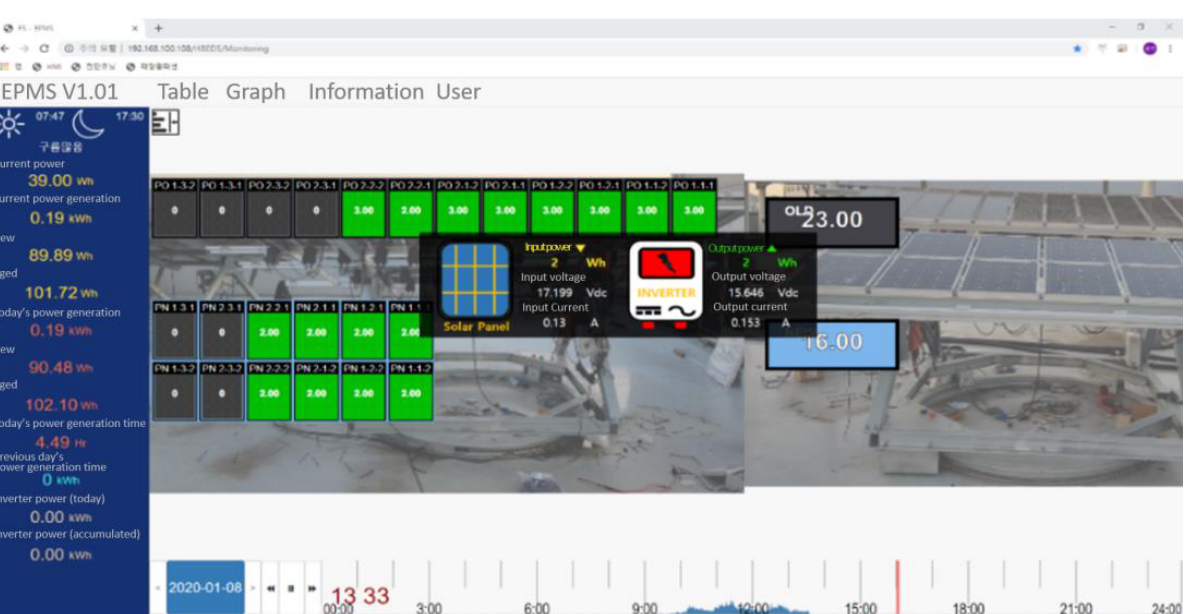
Table 2. Specification of aged and new PV modules.